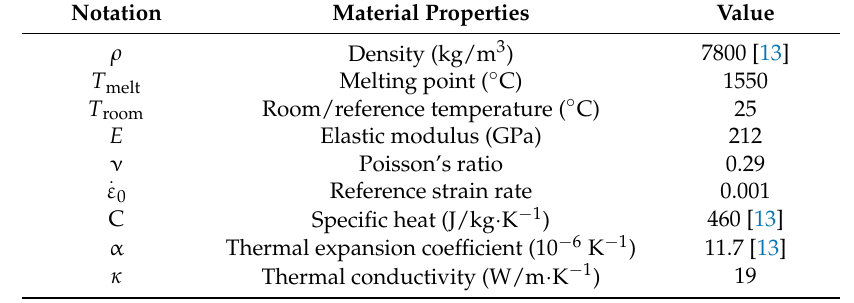
Table 2. Physical and mechanical properties of 45CrNiMoVA used for simulation.